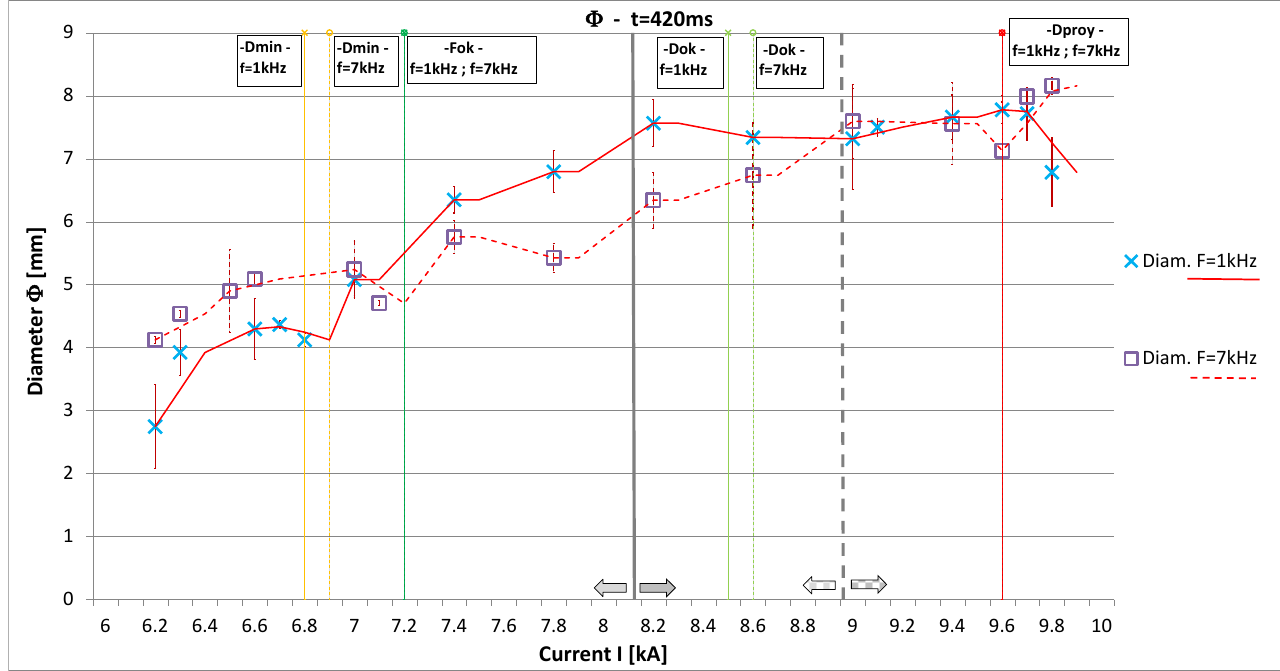
Figure 11. Nugget diameter corresponding to 1 kHz and 7 kHz frequencies. Limit values D min and D proy and optimal F ok and D ok for both frequencies.